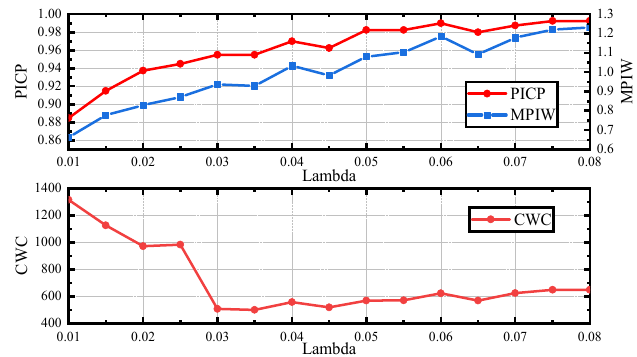
Figure 5. Relationship between the weight parameter and the value of PICP, MPIW and CWC when using AB loss.